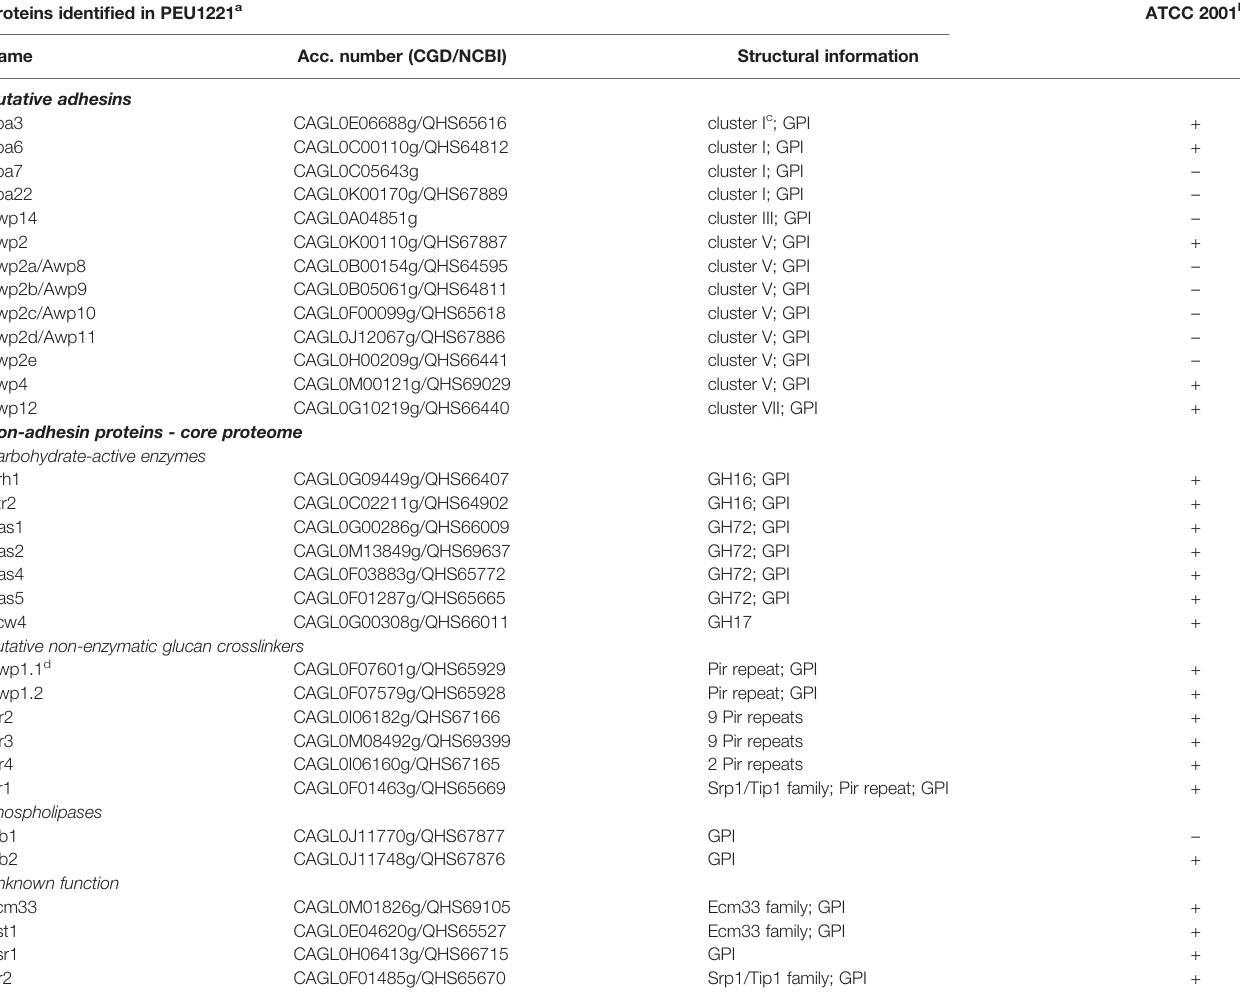
TABLE 1 | Identi fi ed cell wall proteins in bio fi lm cells of hyperadhesive C. glabrata isolate PEU1221, and comparison to reference strain ATCC